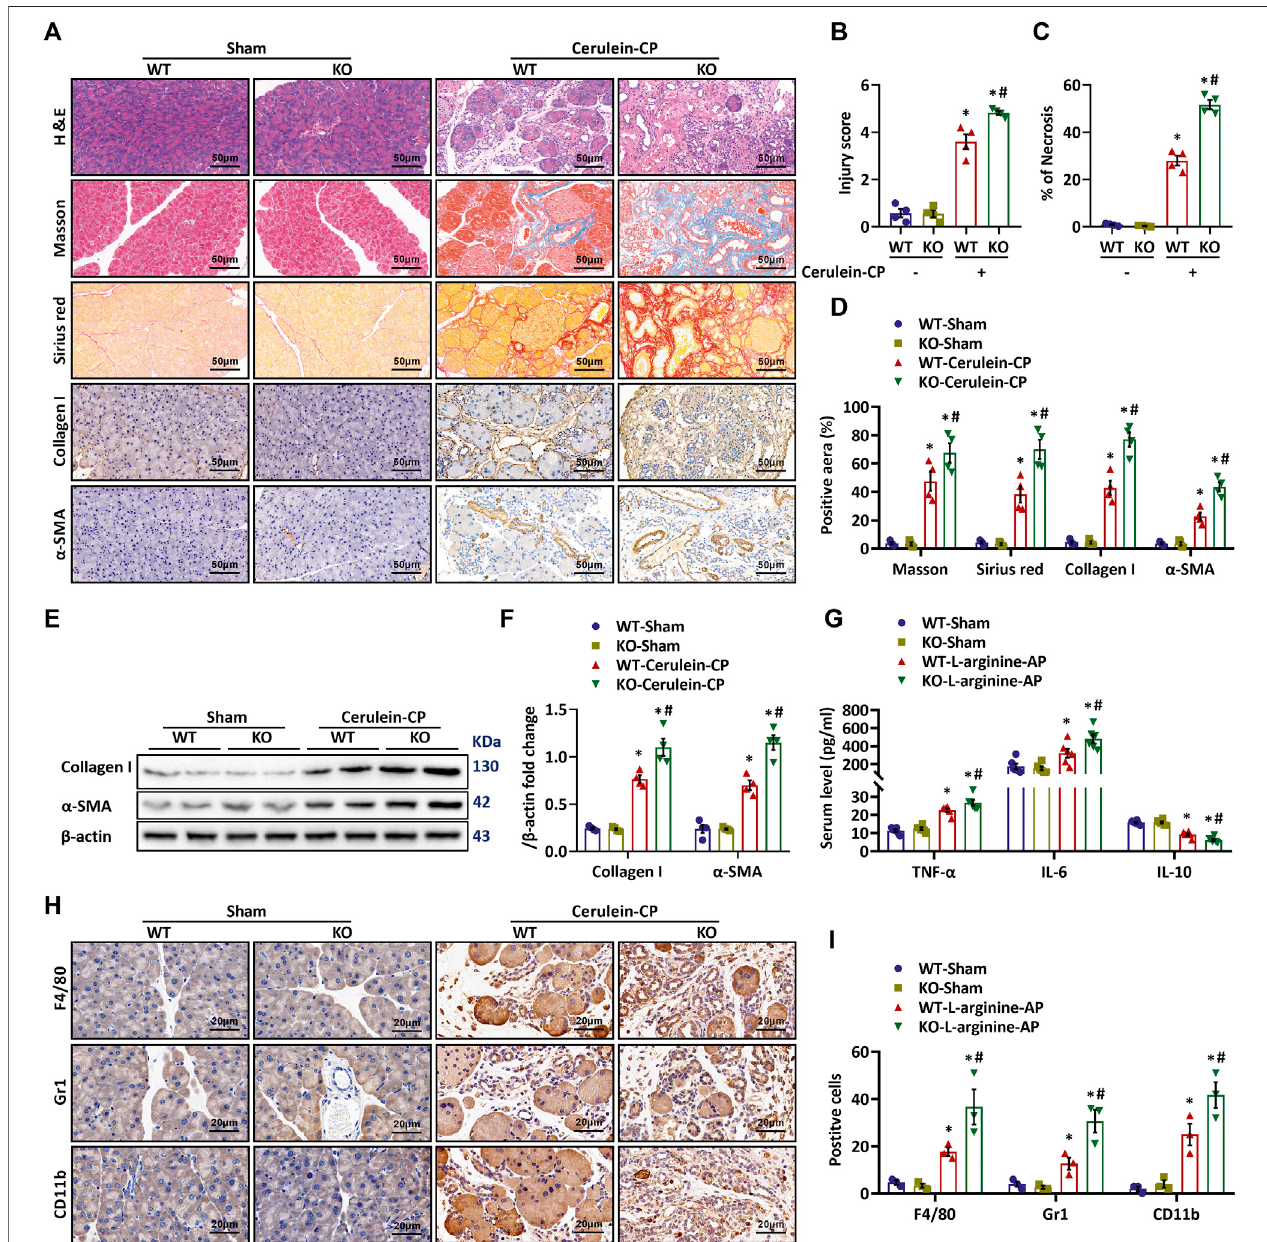
FIGURE 1 | MFG-E8 De fi ciency Potentiates Cerulein-Induced CP in Vivo . Cerulein-CP was induced by six IP injections of cerulein (50 μ g/kg/body weight) twice a week for 10 weeks. During the last 5 weeks, 1 h after cerulein injection, normal saline (vehicle) or 20 μ g/kg MFG-E8 was administered through intraperitoneal injection. Thecontrolgroup received thesame frequencyand timeofintraperitoneal injection ofnormal saline (Sham). The animals were sacri fi cedat 2 days after the last injection of cerulein or normal saline. Blood and tissue samples were collected. (A) Representative photos of H&E, Sirius red, Masson, Collagen I and α -SMA staining; (B) Quantitative analysis of H&E staining (one-way ANOVA with the Tukey-Kramer test); (C) Percentages of necrotic areas (one-way ANOVA with the Tukey- Kramer test); (D) Quantitative analysisof Sirius red Masson, Collagen I and α -SMA staining (one-way ANOVA with the Tukey-Kramer test); (E,F) Westernblot analysisof the expression of α -SMA and collagen I in the pancreas (one-way ANOVAwith the Tukey-Kramer test); (G) Serum levels of IL-6, IL-10 and TNF- α (one-way ANOVA with theTukey-Kramer test); (H,I) Representativephotos andquantitativeanalysisofF4/80,Gr1 andCD11b staining(one-wayANOVAwiththeTukey-Kramer test). n (cid:1) 4 – 6, mean ± SEM; p p < 0.05versusShamgroup;# p < 0.05versusVehiclegroup.CP,chronicpancreatitis;H&E,hematoxylinandeosin; α -SMA,alpha-smoothmuscleactin; WT, wild type; KO, knock